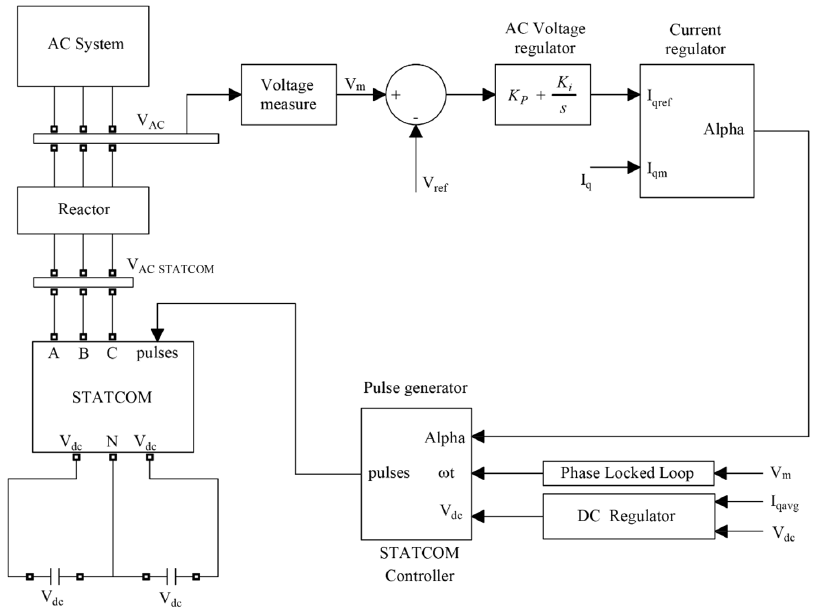
Figure 4. STATCOM control scheme.